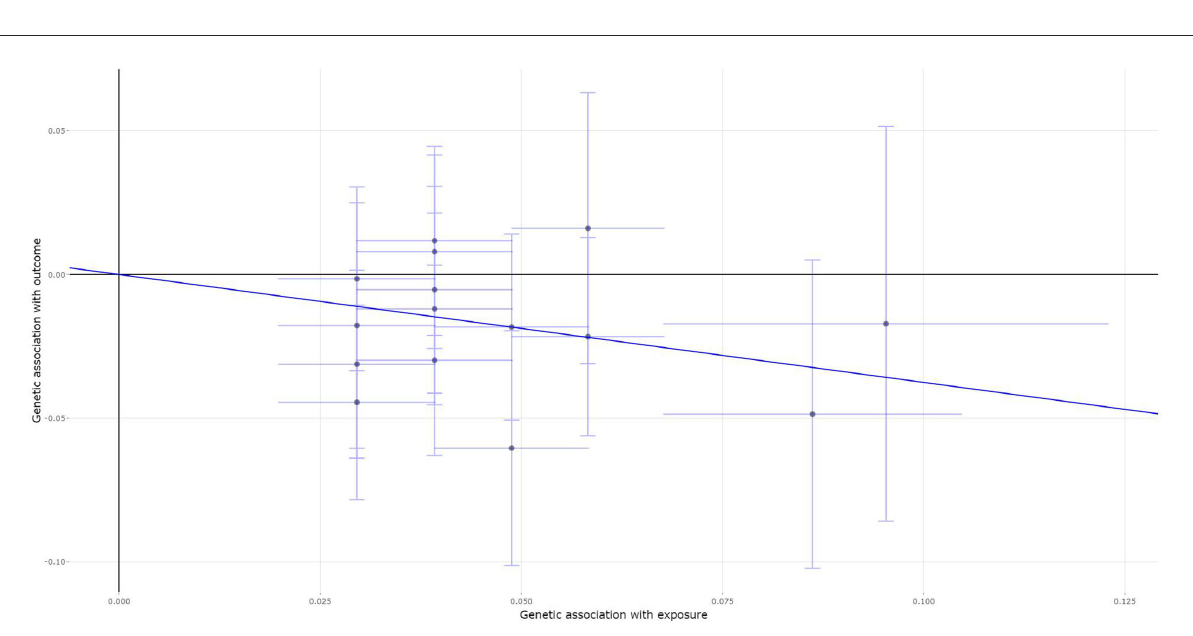
FIGURE3 The scatter plot for the MR analysis showing the causal estimates of fracture on the risk of MS using the inverse-variance weighted (IVW) method.